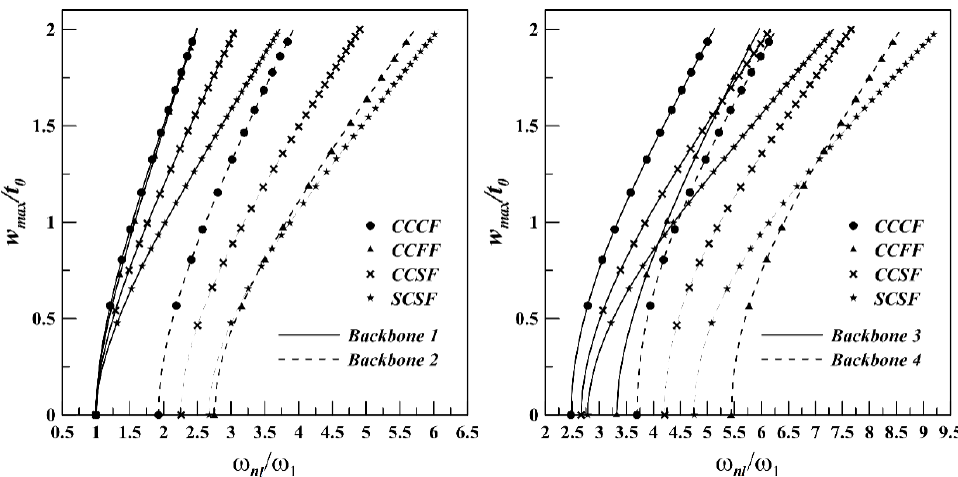
Figure 4: Effect of boundary conditions on backbone curves at K f = 0 and α , β = 0.5